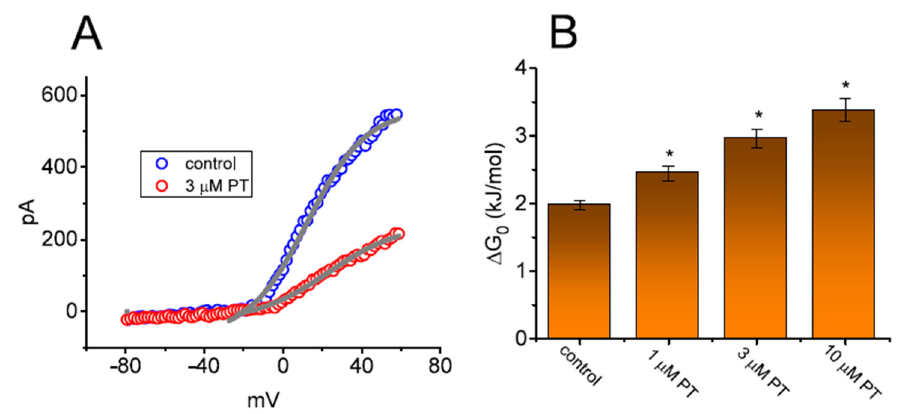
Figure 7. Effect of PT-2385 on the change in free energy at 0 mV ( ∆ G 0 ) required for elicitation of I K(DR) by ramp-up depolarization. ( A ) Representative instantaneous current traces elicited by the upsloping limb of upright ITRV at a duration of 3.2 s (or with ramp speed of ± 87.5 mV/s). The continuous gray lines achieved with or without PT-2385 addition were least-squares fitted to the Boltzmann equation. The values of V 1/2 or q (apparent gating charge) activated by upright ITRV with a duration of 3.2 s in the absence ( ○ ) and presence ( ○ ) of 3 µM PT-2385 were estimated to be +12.3 mV or 1.7 e and +23.0 mV or 1.3 e , respectively. ( B ) The relationship of the free energy level at 0 mV ( ∆ G 0 ) versus the different PT-2385 concentrations (mean ± SEM; n = 7 for each bar). The estimation of DG 0 is elaborated under Materials and Methods. Of note, increasing PT-2385 concentrations resulted in higher values of ∆ G 0 identified in GH 3 cells. * Significantly different from control ( p < 0.05).